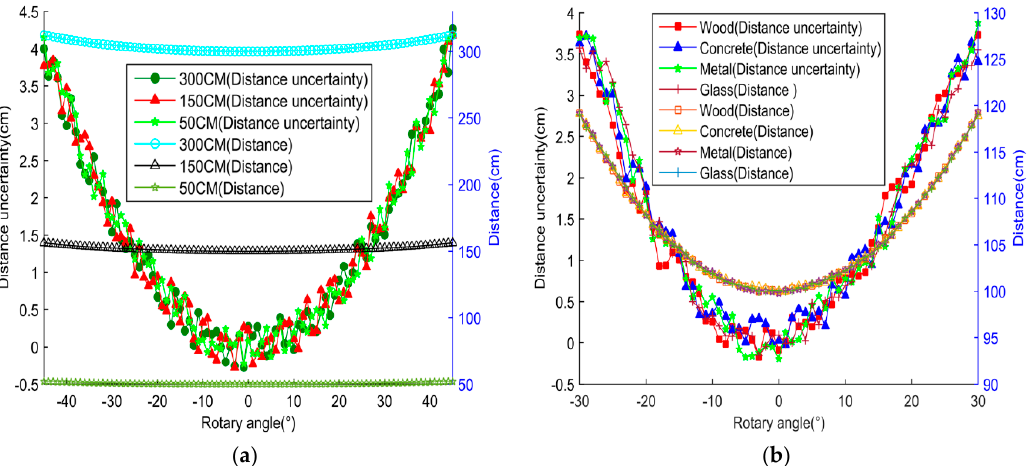
Figure 2. Detected data results. ( a ) Distance and its error at different angles; ( b ) distance and its error with different materials.